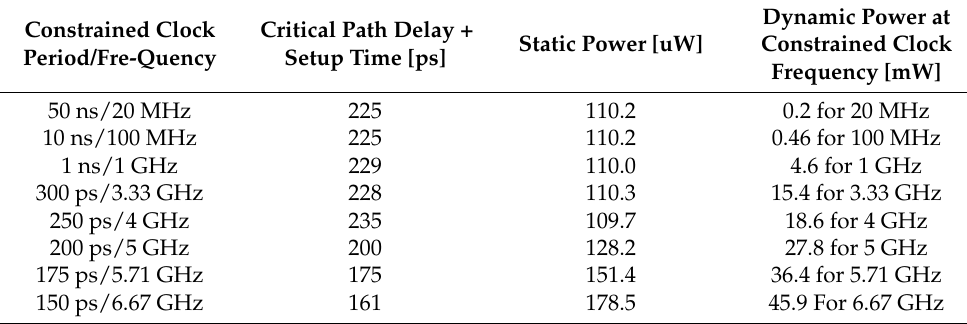
Table 4. Summary of the synthesis results (delay, power) of the DST processing chain.